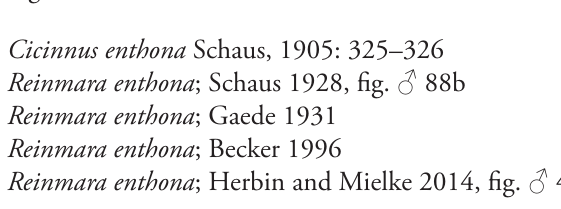
apex sharply acute, falcate. Male genitalia: phallus thin, strongly curved, and hook-like in shape (Fig. 30c) ................................................. R. ignea sp. n. Male: Forewing postmedial line not outwardly lined with black suffusion from tornus to apex. Female: Forewing postmedial line not inwardly lined with light pink-gray suffusion, medial area pink suffused ............................ 3 – Male: Forewing postmedial line outwardly lined with black suffusion from tornus to apex. Female: Forewing postmedial line inwardly lined with light pink-gray suffusion, medial area largely displaying the light brown ground color, not suffused with pink ........................................................ R. minasa 3 Forewing with deep notch at tornus, eastern slopes of the Andes mountains ... 4 – Forewing smooth at tornus, notch absent, west of Andes .............................. Phallus mostly cylindrical in shape, not distinctly broadened distally, found in the Amazon rainforest, moderate elevations of the Andes mountains, or – Phallus distinctly broadened distally, endemic to the Cerrado of Brazil and Forewing postmedial line notched toward costa at intersection with Rs4; forewing narrowed apically, slightly falcate, distributed in the Amazon rain- – Forewing postmedial line not notched toward costa at intersection with Rs4; forewing not noticeably narrowed apically, though if somewhat truncated, submarginal area still broader than any other Reinmara species; endemic to eastern slopes of Andes mountains .................................... R. andensis sp. n. 6 Setae-filled diaphragmal sacks of male genitalia well developed, extending into body cavity well beyond vincular ring. Pinkish gray suffusion generally broadly distributed in medial area of forewing. Broadly distributed in the – Diaphragmal sacks of male genitalia half the size of those in R. enthona , sacks hardly extending into body beyond vinculum. Gray suffusion of medial area restricted to apical confluence of postmedial line with costa. Endemic